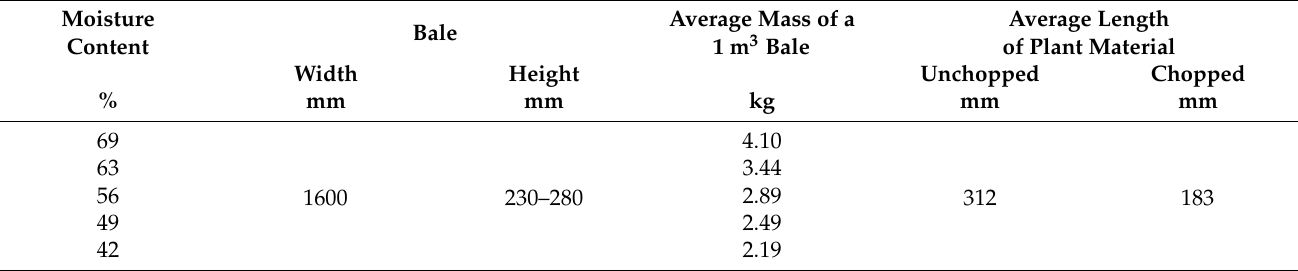
Table 2. Characteristics of the Barenbrug BG-5 forage